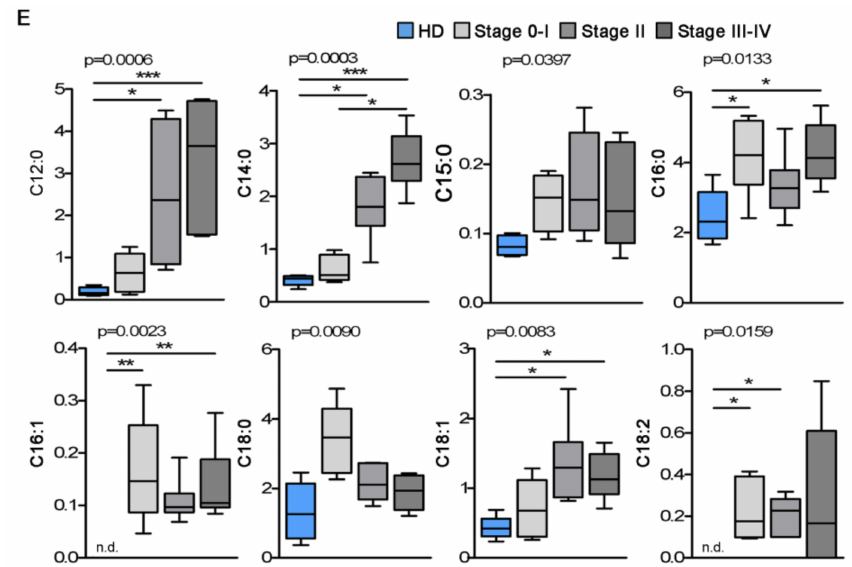
Figure 2. Fatty acids in total sEV and CD81sEV. ( A ) Analysis by gas chromatography of FA in total sEV from HD and melanoma patients. ( B ) C18:0/C18:1 ratio of the samples in A. ( C ) Gas chromatography and mass spectrometry analysis of FA in CD81sEV from HD and patients. ( D ) The respective C18:0/C18:1 ratios of the samples in C. ( E ) Single FA of stage 0–I, II, III–IV and HD in CD81sEV. n.d. = not detected. Statistical significance was achieved with unpaired t -tests for HD vs. patients and with Kruskal–Wallis and Dunn post-tests for HD vs. stages. * p < 0.05, ** p < 0.001, *** p <